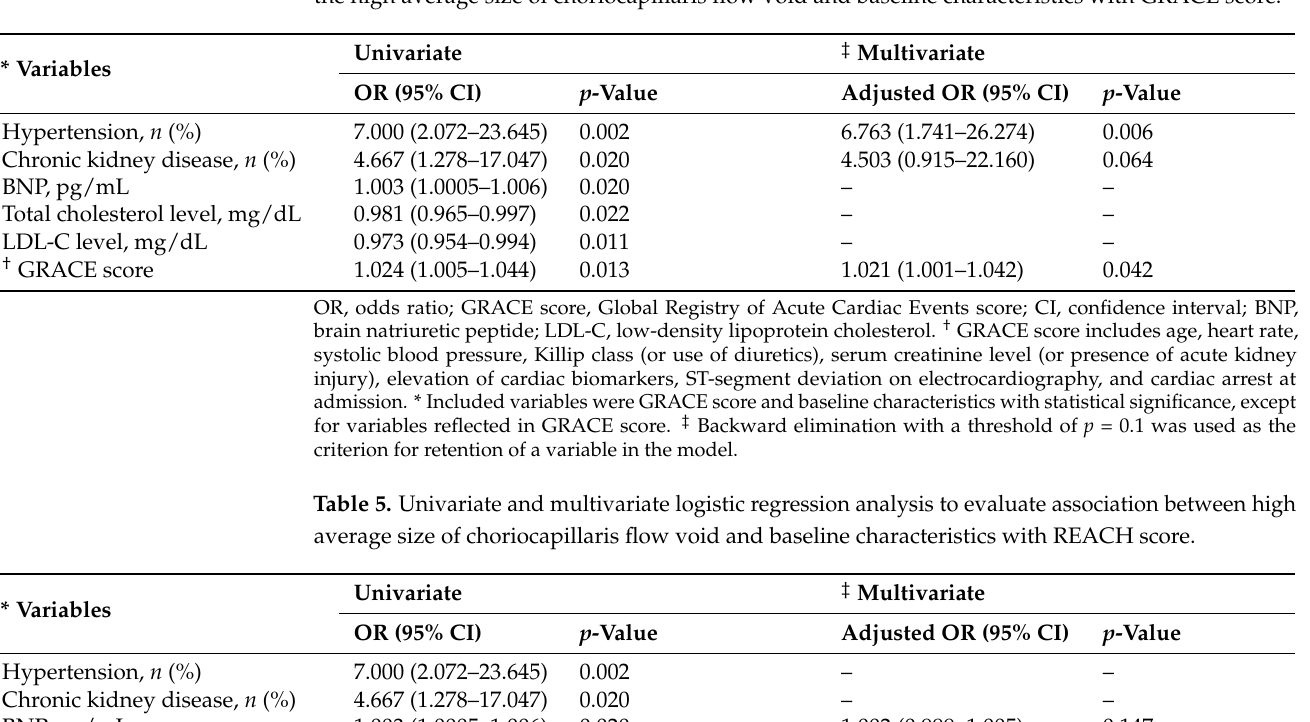
Table 4. Univariate and multivariate logistic regression analysis to evaluate the association between the high average size of choriocapillaris flow void and baseline characteristics with GRACE score.